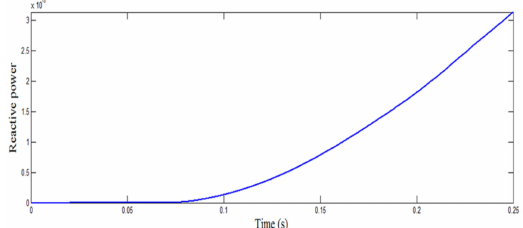
Figure 18. Reactive power demand from the load